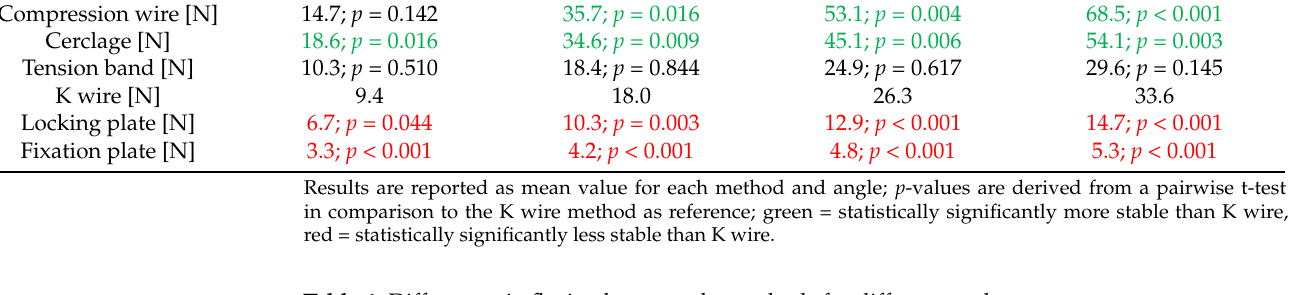
Table 4. Differences in flexion between the methods for different